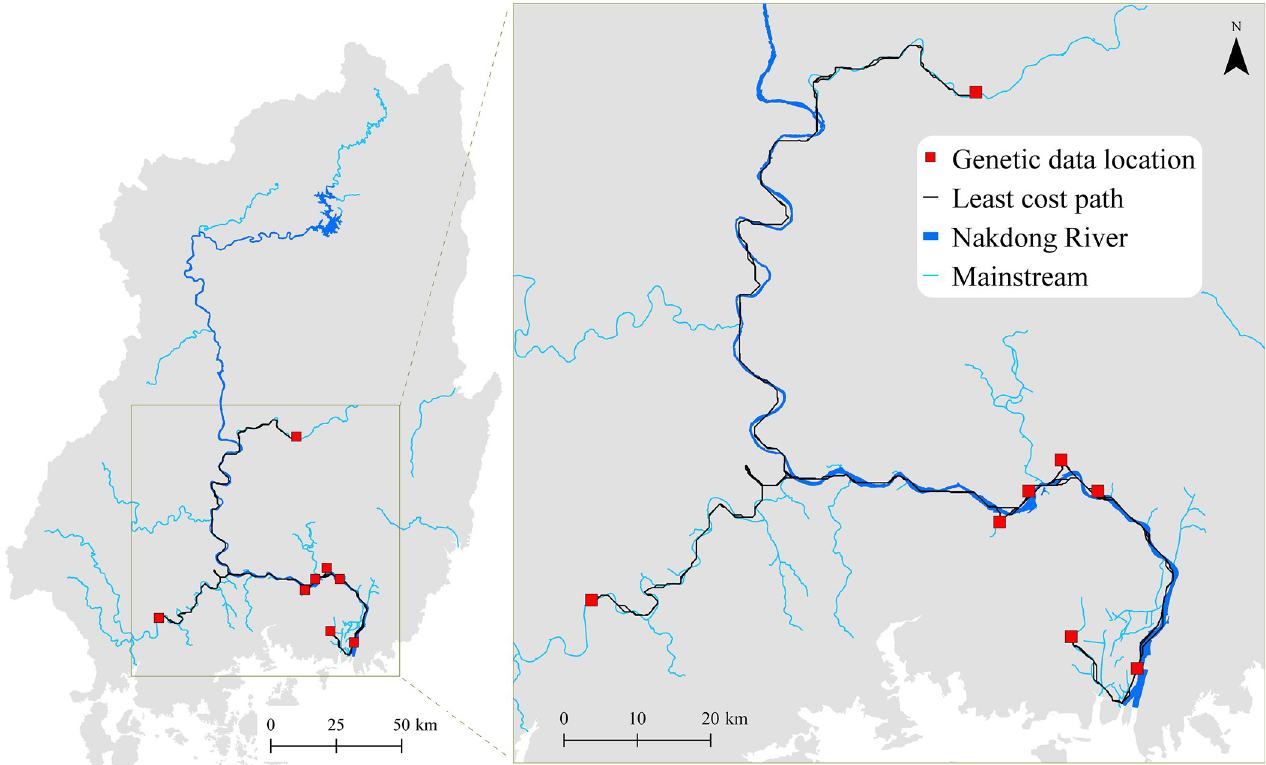
Fig 9. Least-cost paths connecting pairs of eight nutria populations in the Nakdong River Basin (base map data source: https://gadm.org/). The middle and downstream area was enlarged. The genetic data location coordinates were obtained from the study by Kim et al. [28]. River and stream data were derived from the OpenStreetMap database